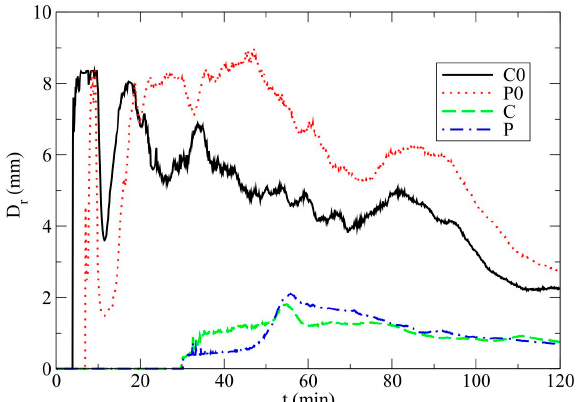
Figure 5. The maximum values of the mean diameter of raindrop spectrum (mm) for clean air without drizzle (C0) and with drizzle (C) and polluted air without drizzle (P0) and with drizzle (P).